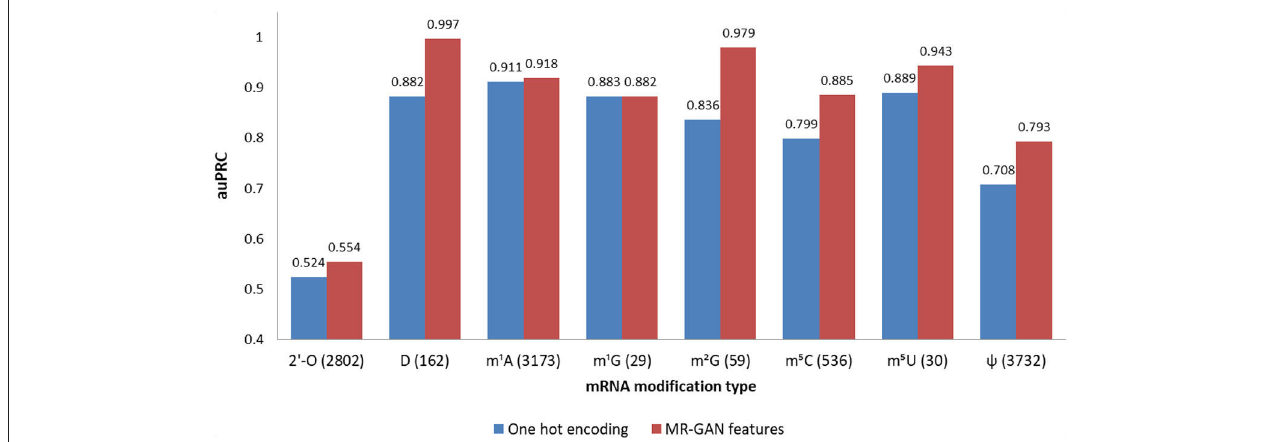
FIGURE 2 | Prediction performance (auPRC) of eight epitranscriptome modifications using MR-GAN features and one-hot encoding. The number next to a modification name is the number of corresponding positive samples. The auPRCs are listed on top of the bars.